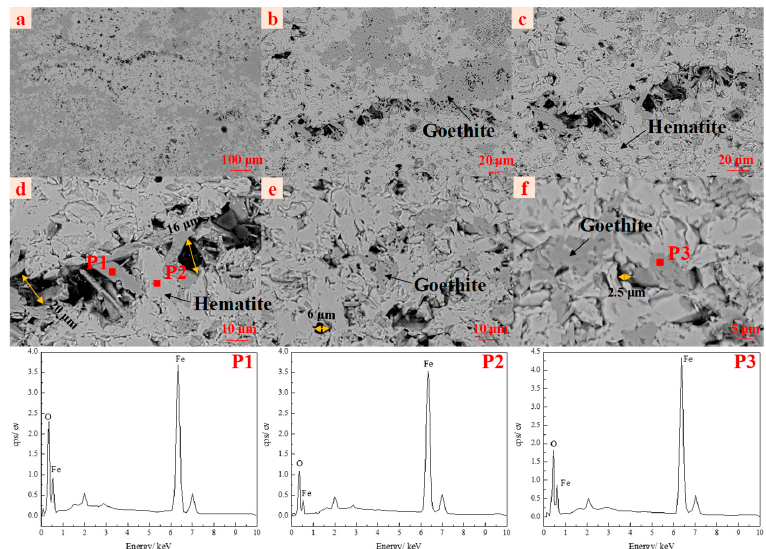
Figure 2. Microstructure and EDS results of #2 iron ore. ( a ) Microstructure image with 100 μ m scale; ( b ) Microstructure image with 20 μ m scale; ( c ) Microstructure image with 20 μ m scale; ( d ) Pore structure with 10 μ m scale; ( e ) Pore structure with 10 μ m scale; ( f ) Pore structure with 5 μ m scale; ( P1 ) EDS results for hematite in ( d ); ( P2 ) EDS results for goethite in ( d ); ( P3 ) EDS results for goethite in ( f